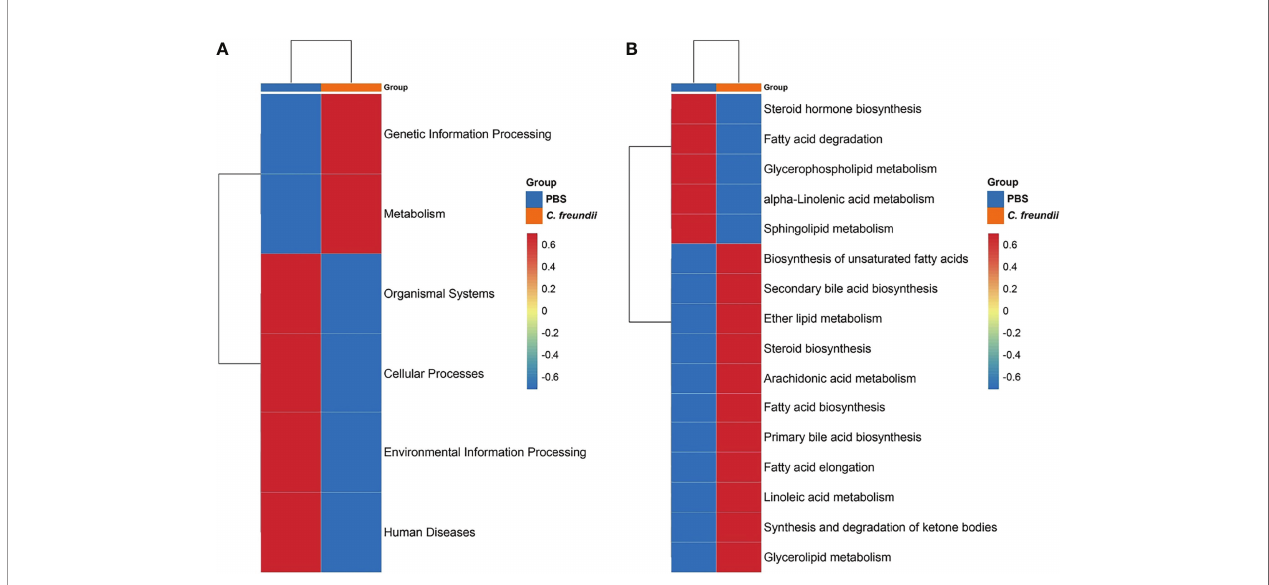
FIGURE 2 | Prediction of intestinal microbiota function. (A) KEGG functional abundance statistics based on Tax4Fun. (B) Comparison of the abundance of lipid metabolism-related pathways. Representative values were normalized, colors indicate high (red) or low (blue) abundance of pathway annotations, and pathways were grouped by hierarchical clustering and illustrated at the right side of the heat